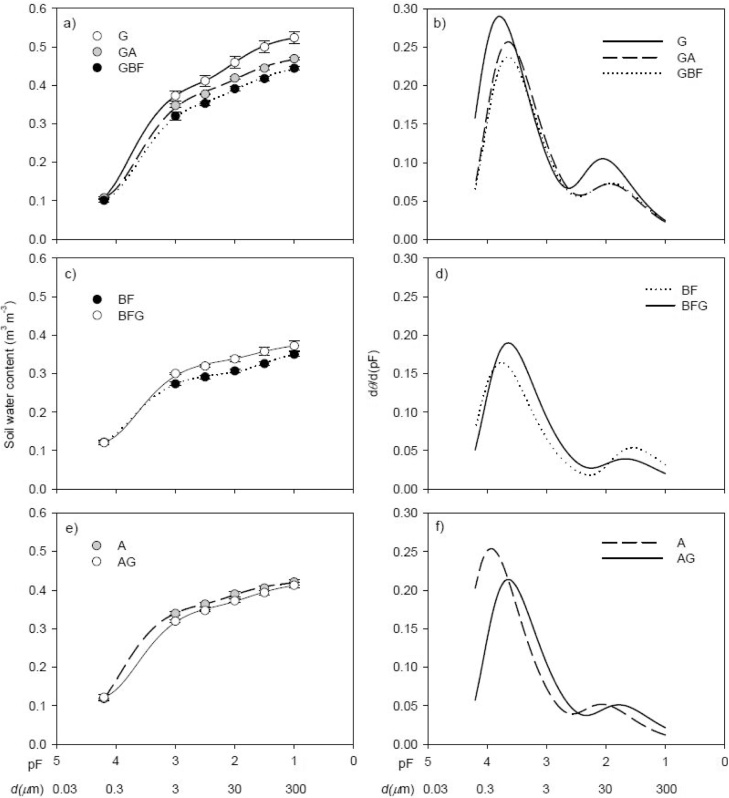
Measured volumetric water content for the comparison of G with GA and GBF (a), BF with BFG (c) and A with AG (e) and fits of the double-exponential (Dex) model as a function of matric potential (pF = log10(|-cm H2O|)). The standard error of the mean is indicated. Pore size distribution (dq/d(pF)) as a function of matric potential for the corresponding comparisons (b, d and f). Eq. 4 was used to obtain the pore size distributions. The equivalent pore diameters are indicated and were estimated by Eq. 2. For treatment abbreviations, see Table 1.